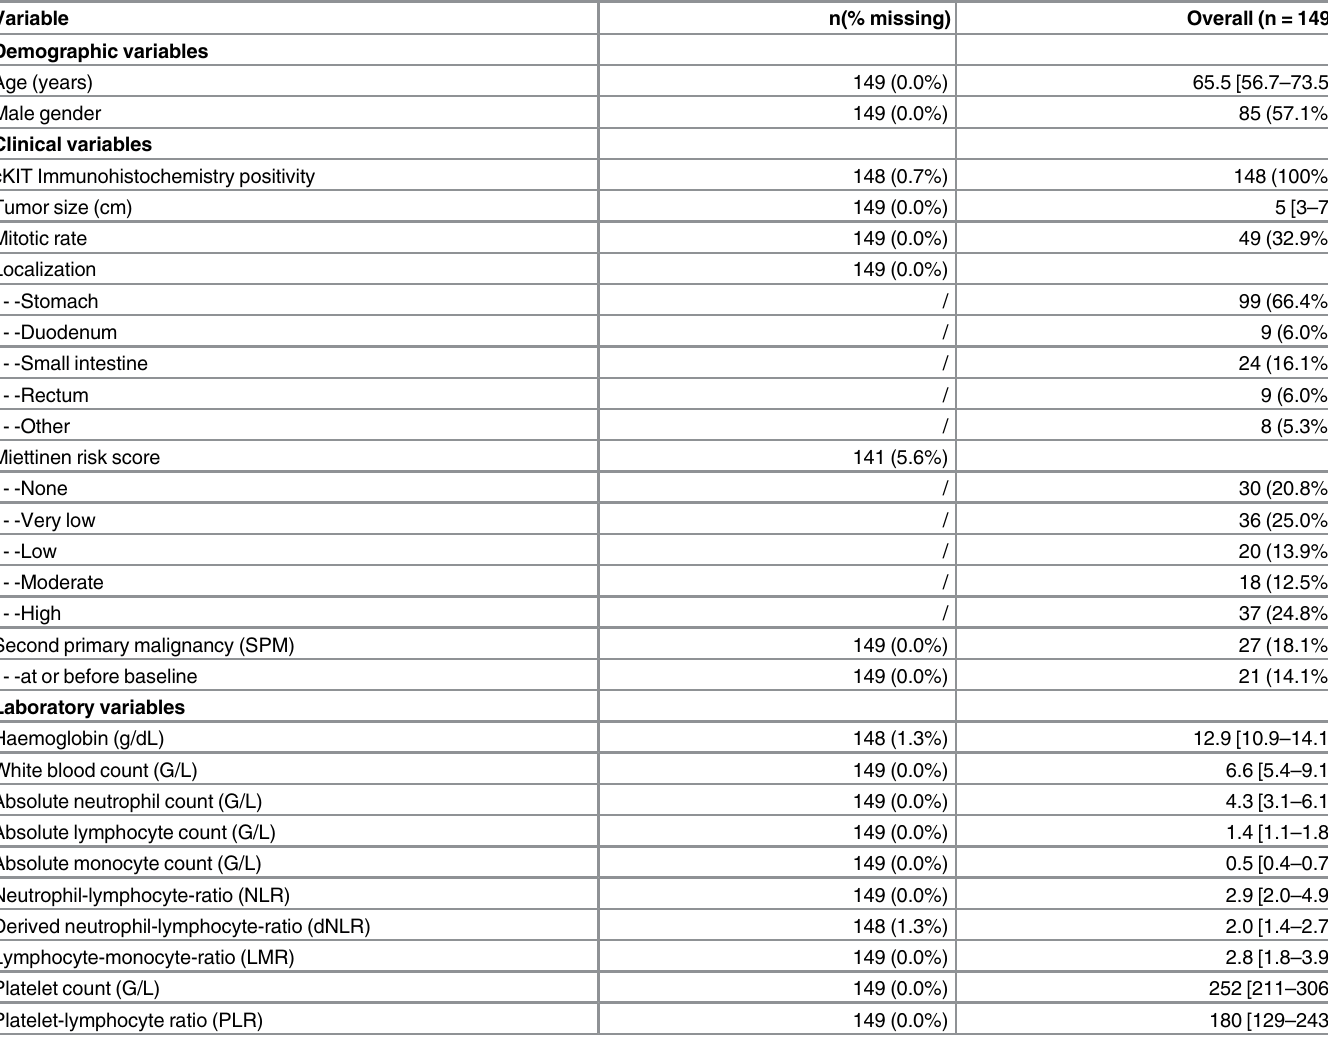
Table 1. Baseline characteristics of the study population. Continuous variables such as age are reported as medians [25 th -75 th percentile], and categori- cal variables such as GIST location are reported as absolute frequencies (%). Abbreviations: cm – centimeter, G/L – giga per